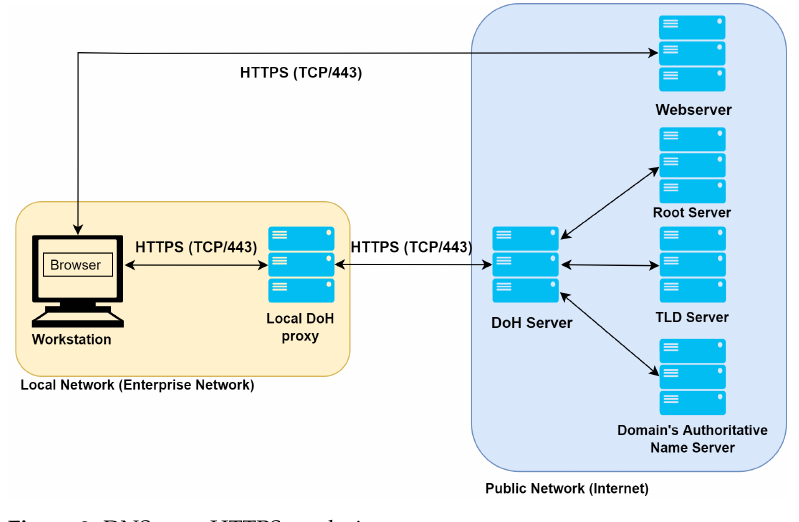
Figure 2. DNS-over-HTTPS